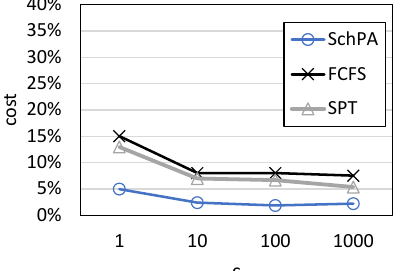
Figure 17. Comparison under varying c .